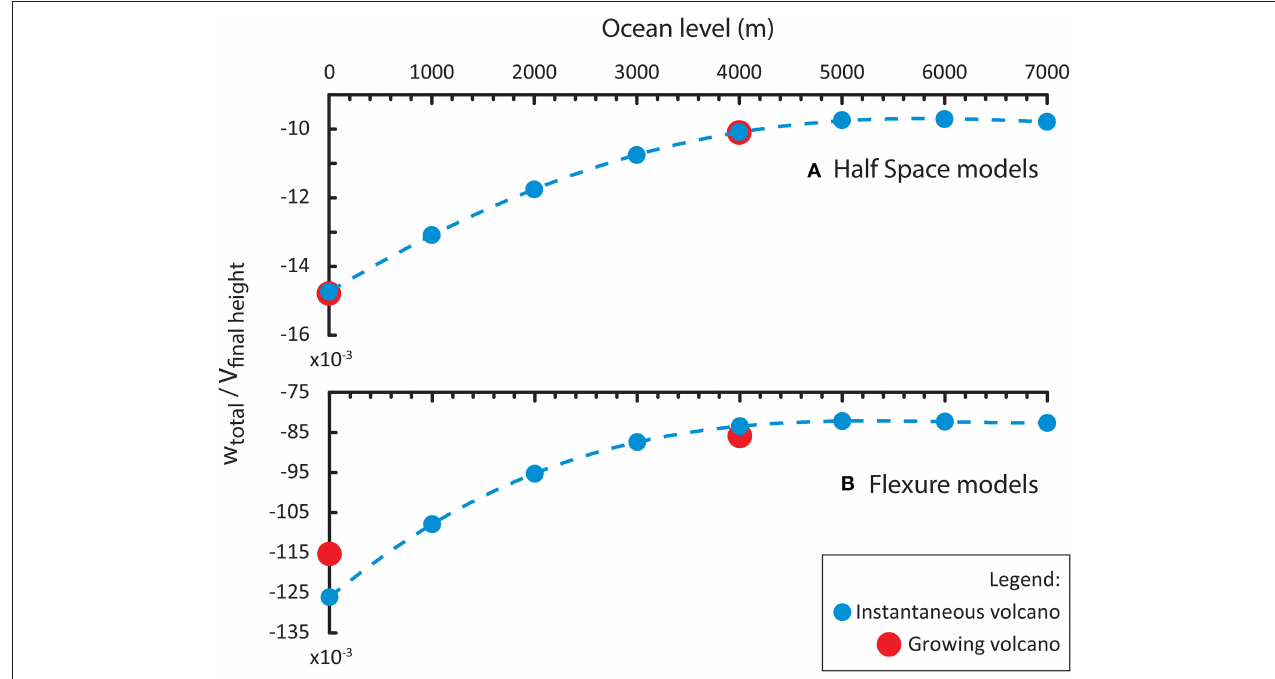
FIGURE 2 | Ratios between the vertical displacements at summit of the volcanic edifice (w) and its the final height (Vh) for instantaneously-formed (blue) and incrementally-grown (red) volcano models. Different sea levels are displayed for instantaneously-formed volcano models (0, 3,000, 5,000, and 7,000m), and for incrementally-grown volcano models (0 or 4,000m). Results for half-space models are shown in the upper panel (A) while results for flexural models are shown in the lower panel (B) .